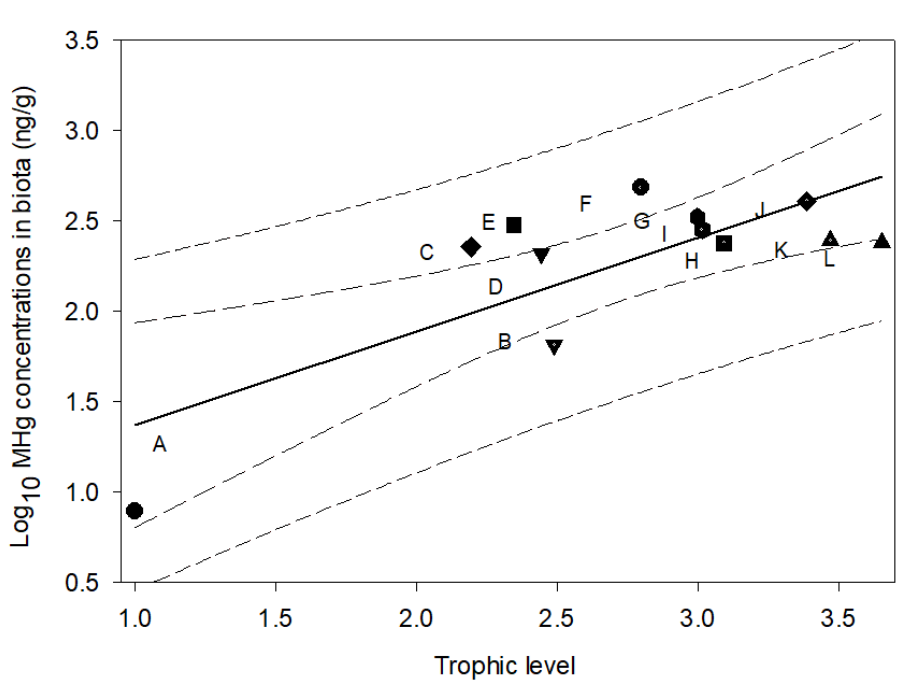
Figure 5. The methylmercury biomagnification model: methylmercury concentrations versus trophic level at the Fourmile Branch. The solid line, the area of dashed lines, and the area of dotted lines indicate the fit of data, 95% CIs, and 95% prediction limits, respectively. The letters A, B, C, D, E, F, G, H, I, J, K, and L indicate biofilm, crayfish, shiner, coastal shiner, creek chubsucker, bluespotted sunfish, spotted sunfish, dollar sunfish, yellow bullhead, grass shrimp, redfin pickerel, and pirate perch, respectively.